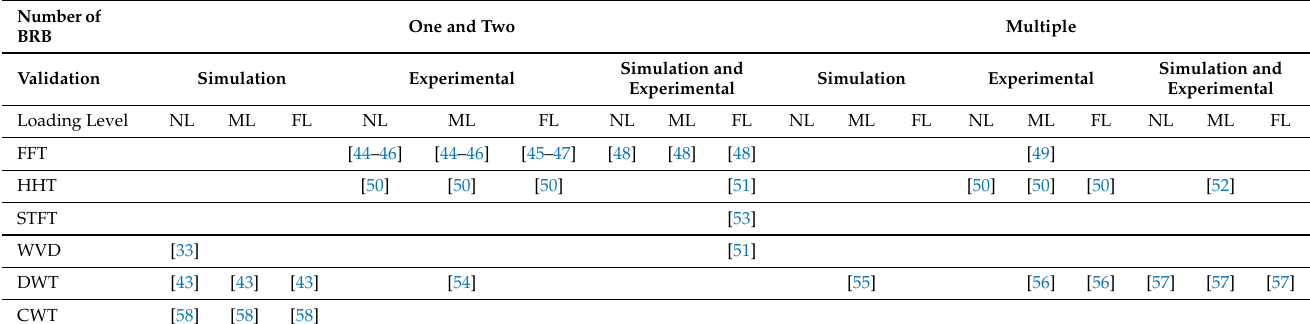
Table 2. Diagnostic classification based on MCSAs using steady-state current.